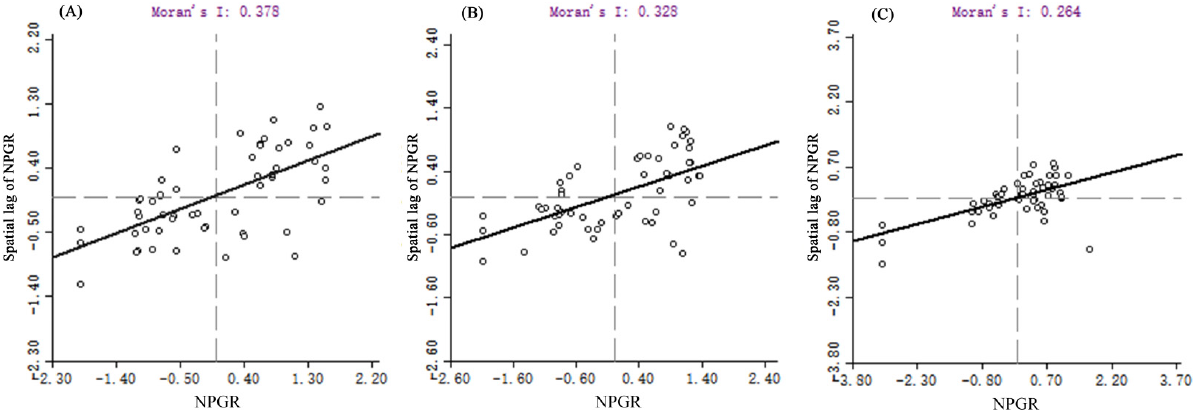
Figure 7. Moran’s I scatter plot of NGPR: ( A ) 2000, ( B ) 2010, and ( C )